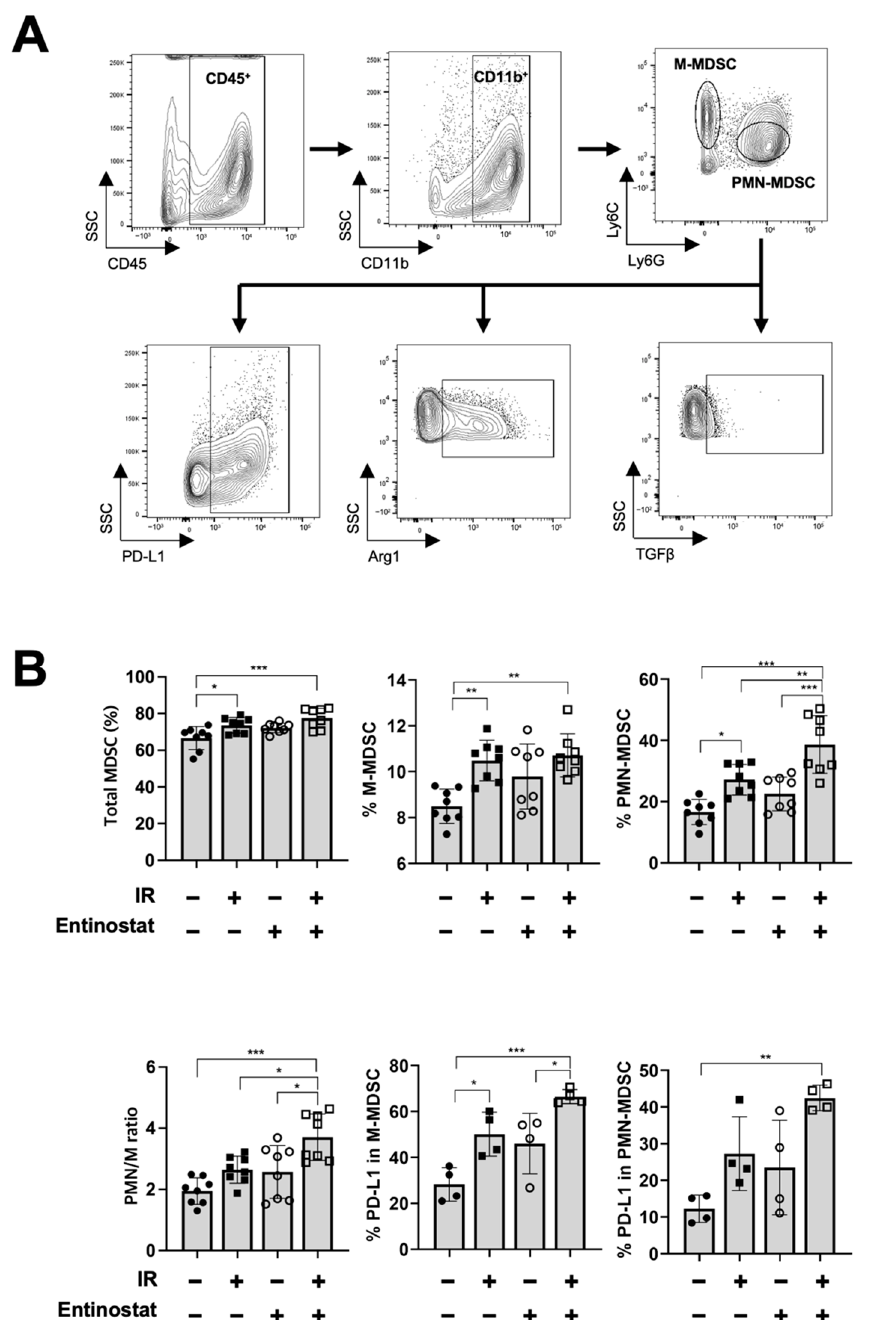
Figure 2. Entinostat modulates radiation-induced MDSC infiltration in tumors. ( A ) Gating strategy for the evaluation of the myeloid-derived suppressor cells (MDSC) population using flow cytometry. Representative density plots are shown. ( B ) Flow cytometric analysis of MDSC populations. Radiation increased the infiltration of total MDSCs in tumors. Entinostat further enhanced PMN-MDSC but not M-MDSC. PD-L1 expression on MDSCs was further increased by IR and entinostat combination. Data are mean ± S.D. ( n ≥ 4). * p < 0.05; ** p < 0.01; *** p <